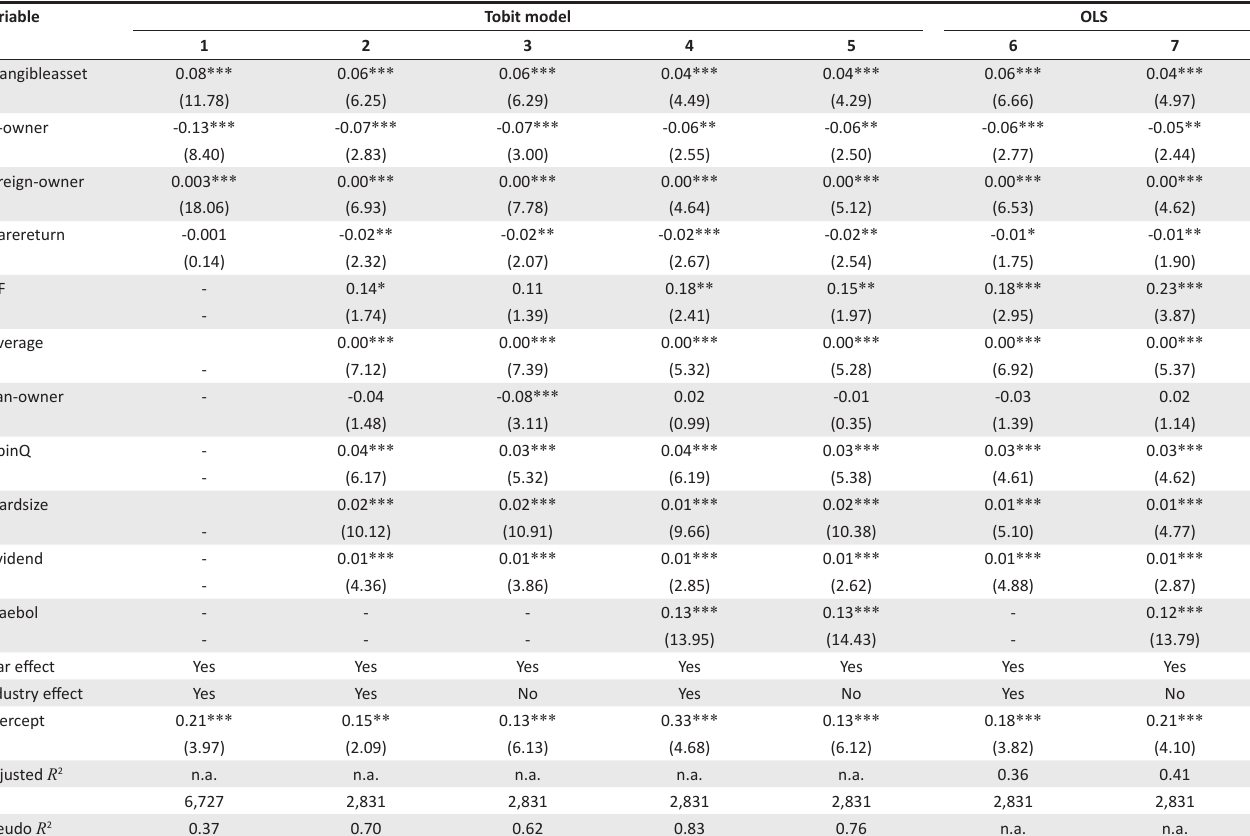
FIGURE 1: Distribution of board structure (ratio of outside directors to board) (number, % TABLE 3: Benchmark estimation results of excessive appointment of outside directors. Variable